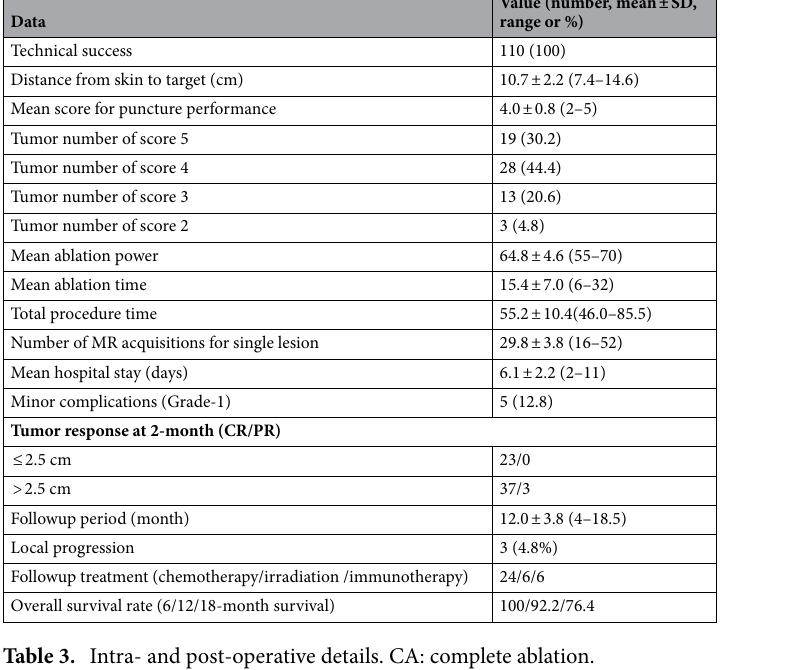
Table 3. Intra- and post-operative details. CA: complete ablation.